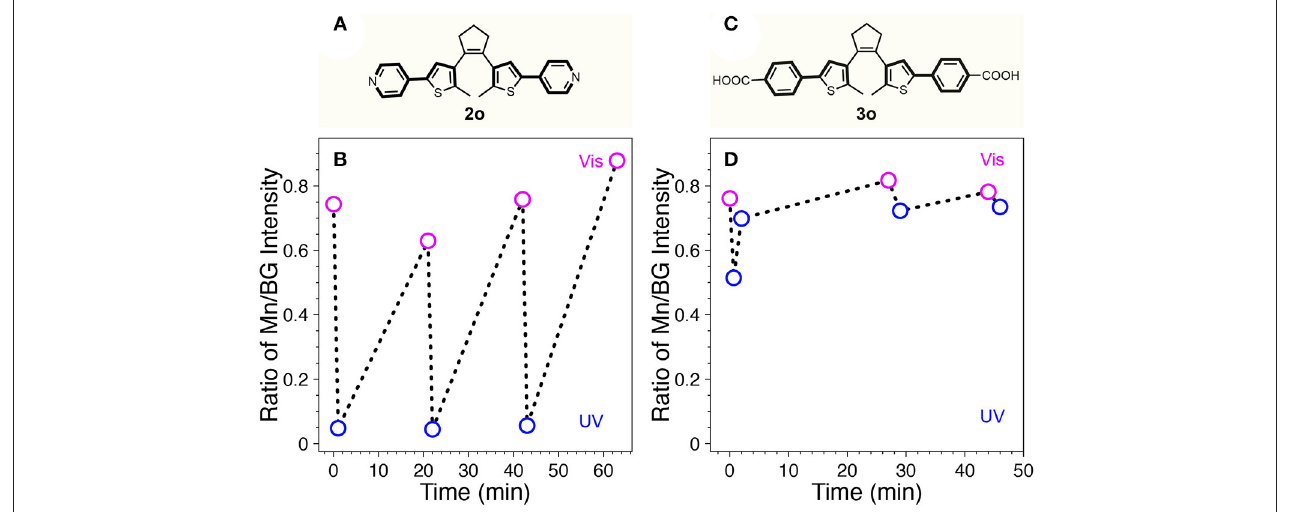
FIGURE 5 | Chemical structures of 2o (A) and 3o (C) . The ratio of Mn/BG-PL intensity of the mixture of Mn-doped CdS-ZnS QDs with 2o (B) or 3o (D) during repetitive switching cycles with sequential UV (blue open circle) and visible (pink open circle) light illumination.